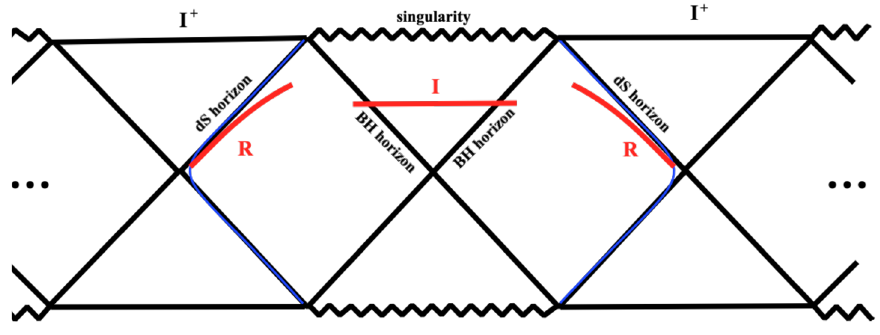
Figure 2 . The Penrose diagram of a Schwarzschild de Sitter black hole, with focus on one black hole “patch” bounded by cosmological horizons on both sides. Depicted are the radiation regions R − ≡ [ r D − , b − ] and R + ≡ [ b + , r D + ] and the late time island I ≡ [ a − , a + ] .